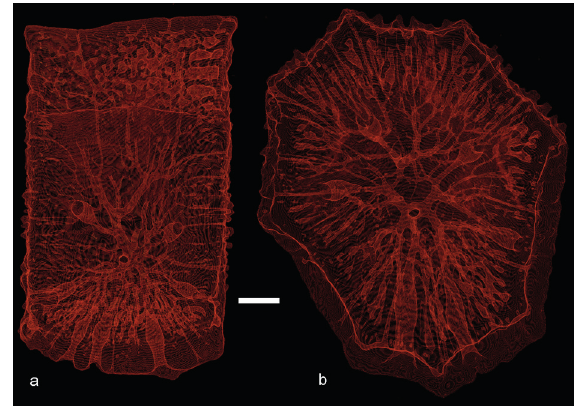
Figure 6 - three-dimensional reconstruction of Dasypus novemcinctus osteoderms; a) LMh 83.2 (movable, anterior to the top); b) LMh 83.1 (buckler). Scale bar = 1